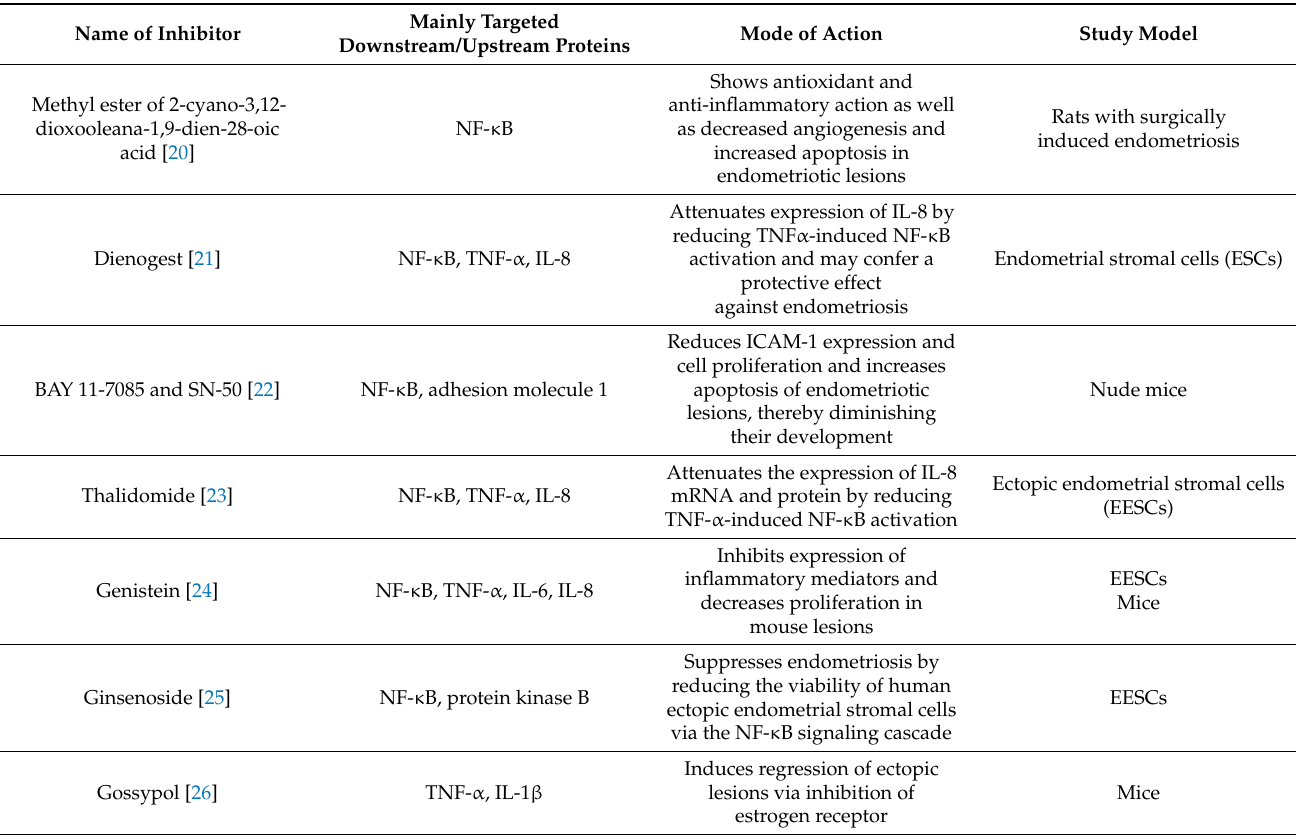
Table 2. List of pharmacological inhibitors targeting NF- κ B and playing an important role in mitigating endometriosis. Name of